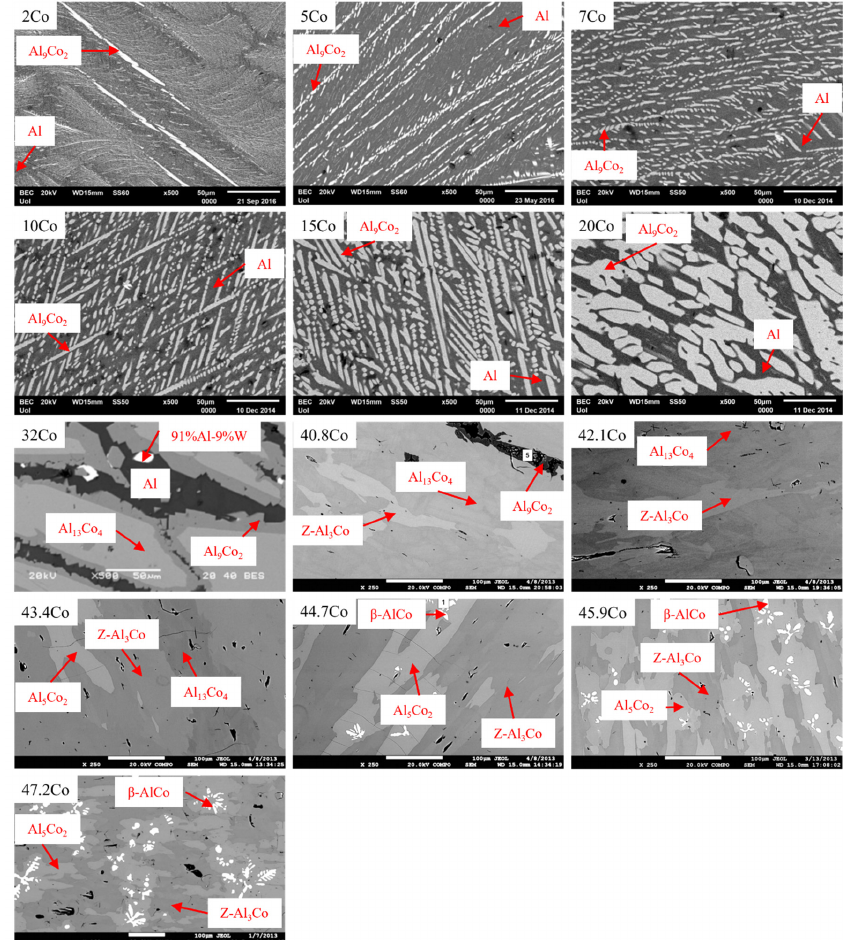
Figure 3. Microstructures (SEM, backscattered electron mode) for Al-Co alloys with different Co compositions (wt % Co) fabricated by vacuum arc melting [72,78–80] (Reprinted with permission from ref. [72,79,80]. Copyright 2022, Elsevier).